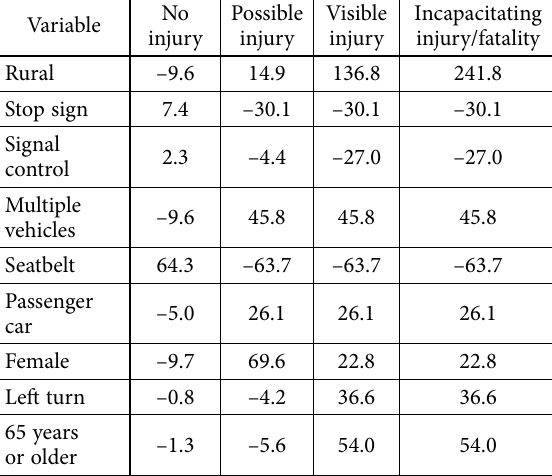
Table 5. Average variable pseudo elasticity